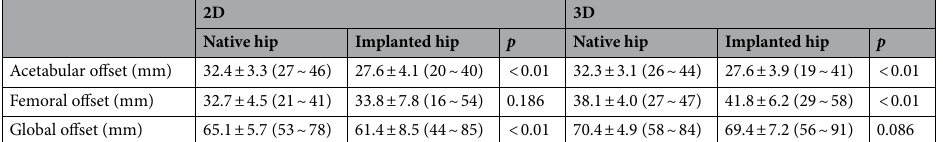
2D 3D Native hip Acetabular offset